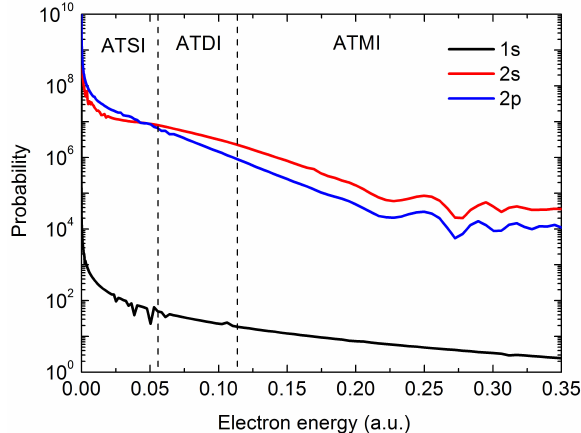
Figure 5. (Color online) Photoelectron spectroscopy (PES) of different initial states of a hydrogen atom exposed to a 800 nm laser with intensity the same as in Figure 3 but the pulse duration is two cycles (6 fs). Here, ATSI, ATDI and ATMI represent the above-threshold single-photon ionization, above-threshold double-photon ionization and above-threshold multiphoton ionization process,